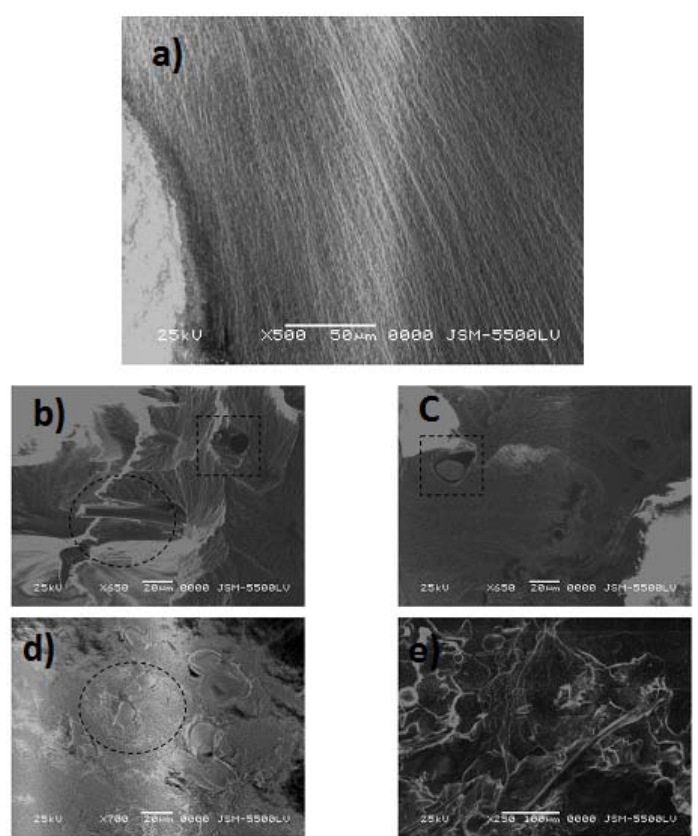
Figure 7. Scanning electron microscope (SEM) microstructure examination of fracture plane ( a ) ABS;